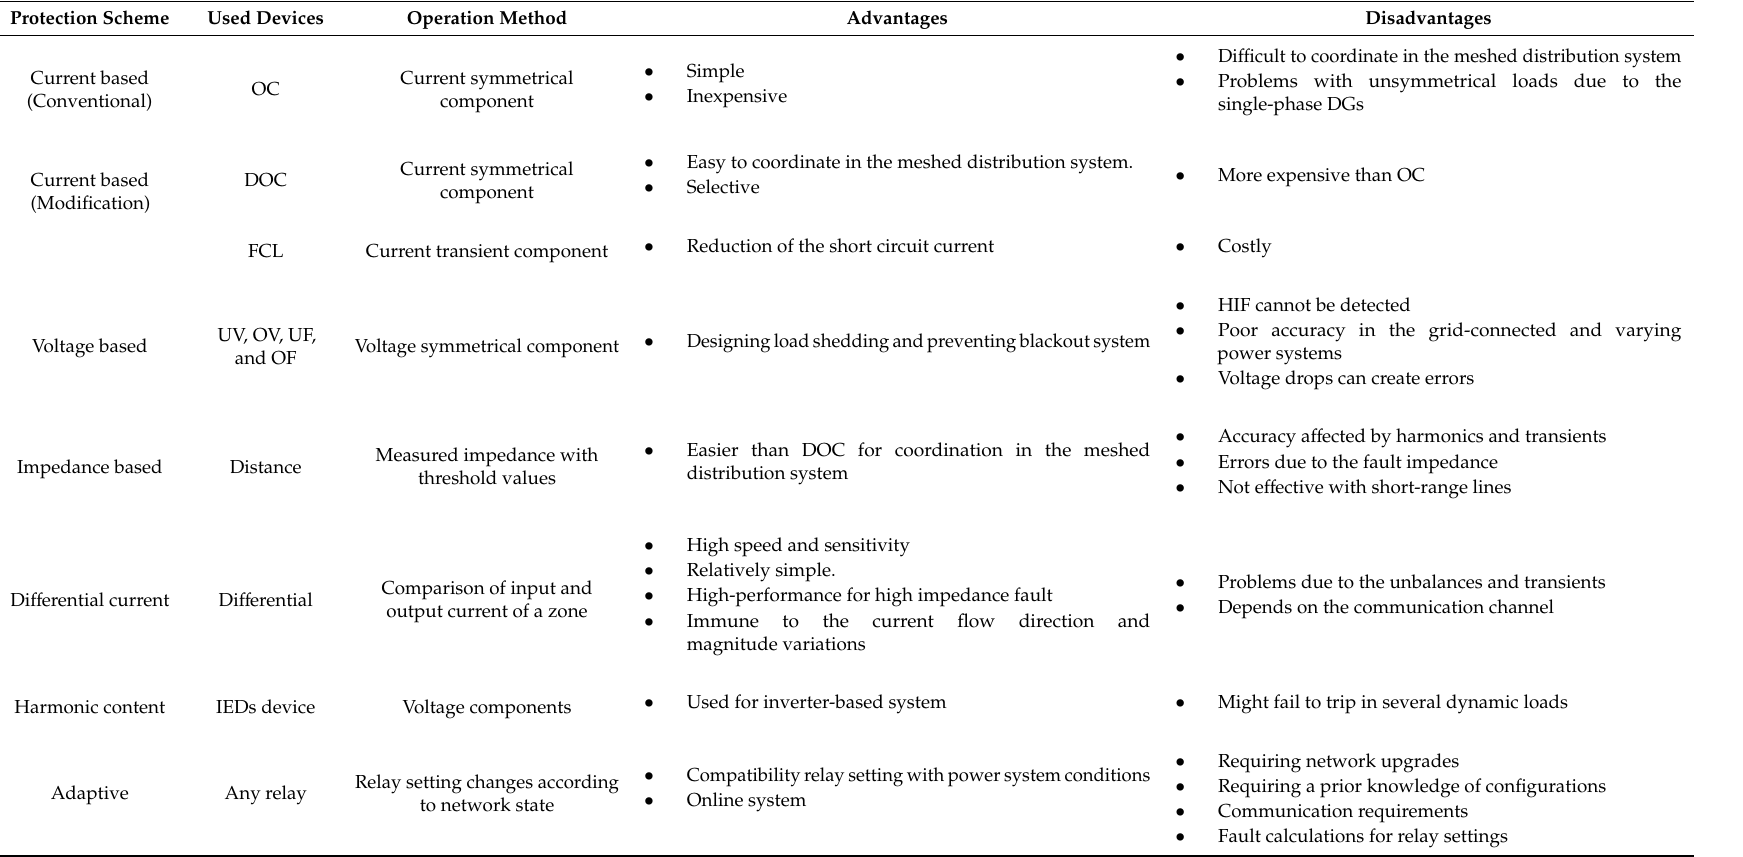
Table 3. Summary of microgrid protection